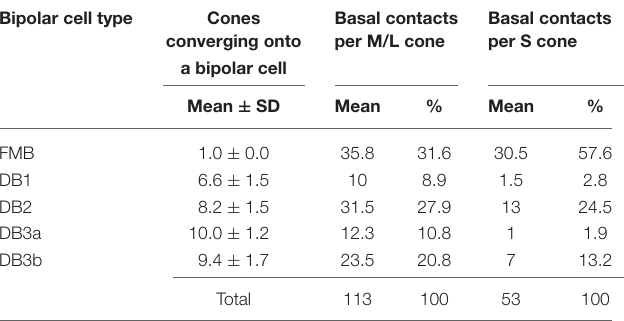
n = 5 for the number of convergent cones, n = 4 for the mean of M/L cones, and n = 2 for the mean of S cones.